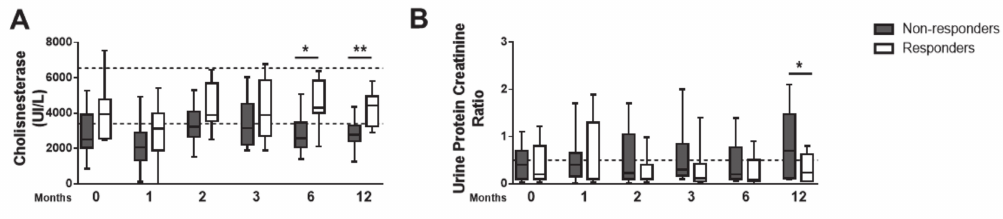
Figure 4. Non-responder dogs develop sub-clinical hepatic and renal lesions. Serum values of cholinesterase ( A ) and urine protein / creatinine ratio ( B ) were quantified at T0, T1, T2, T3, T6 and T12. Data are shown as mean ± SD or in a box and whisker plot format, Responder dogs ( n = 12), Non responder dogs ( n = 14). * p < 0.05; ** p <